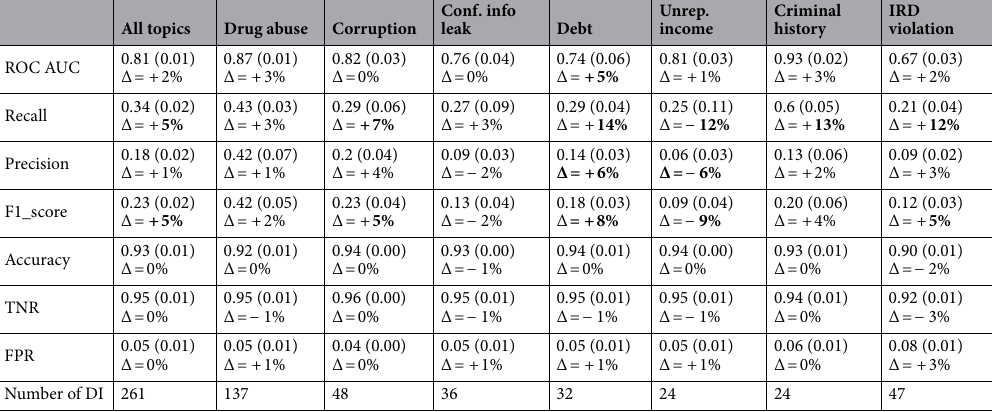
Table 7. Basic model without “IRD violation” and “Unreported income” topics in the train set. Significant values are in bold.